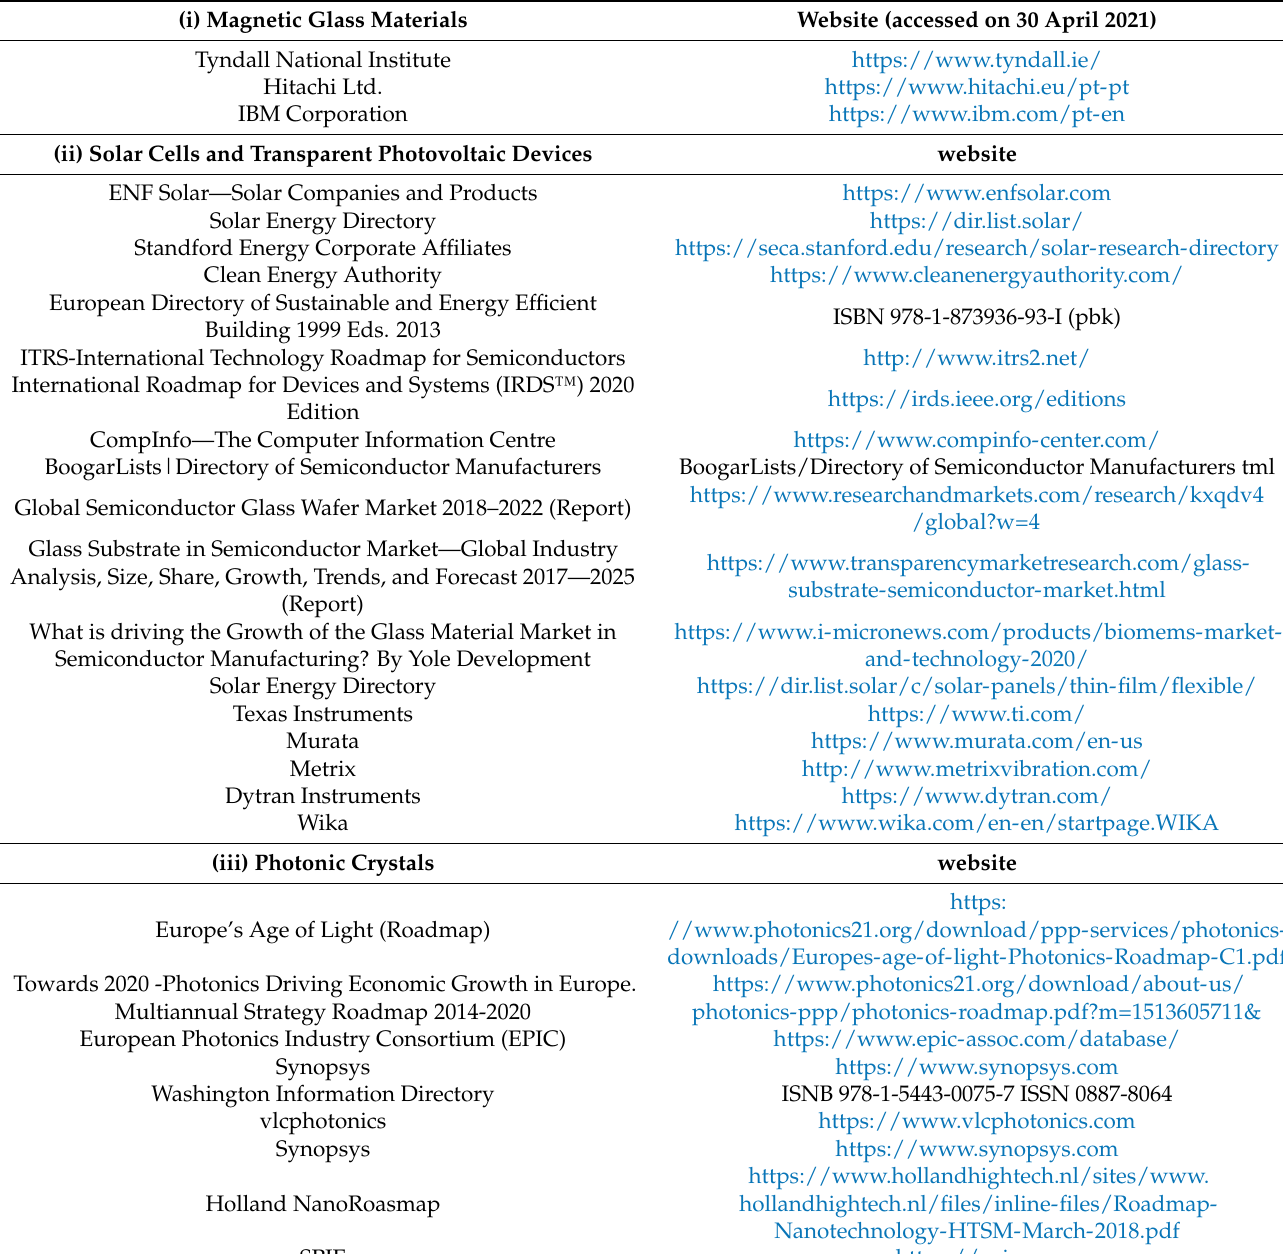
Table 4. Industrial directories for high-end materials in different